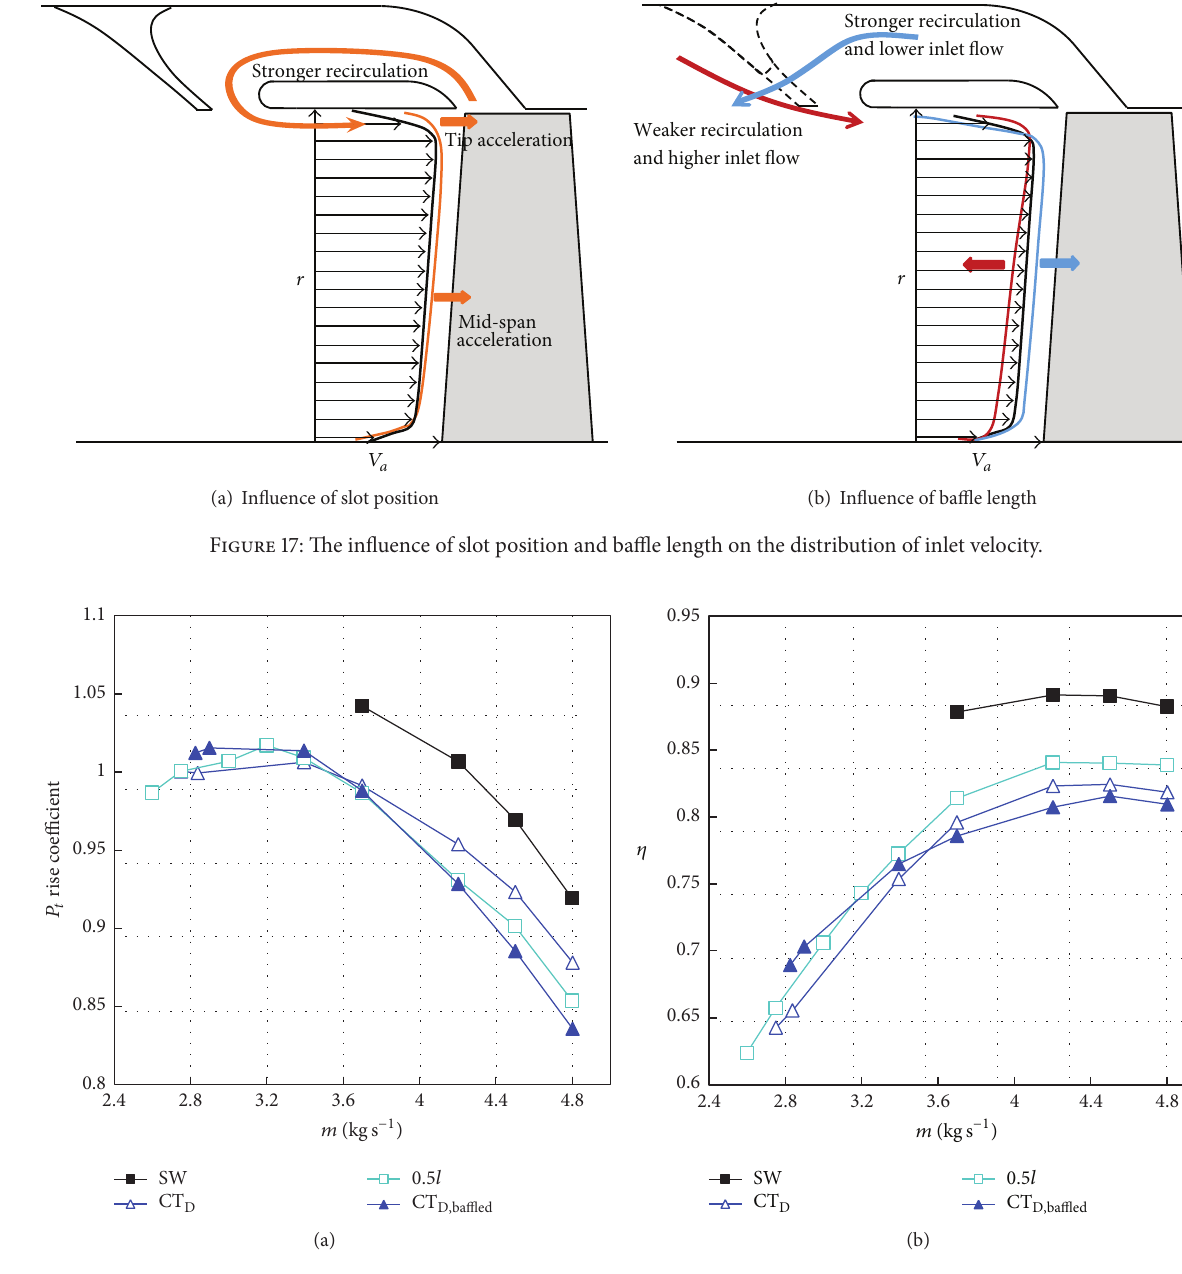
Figure 18: Total performance of downstream slot with different baffle